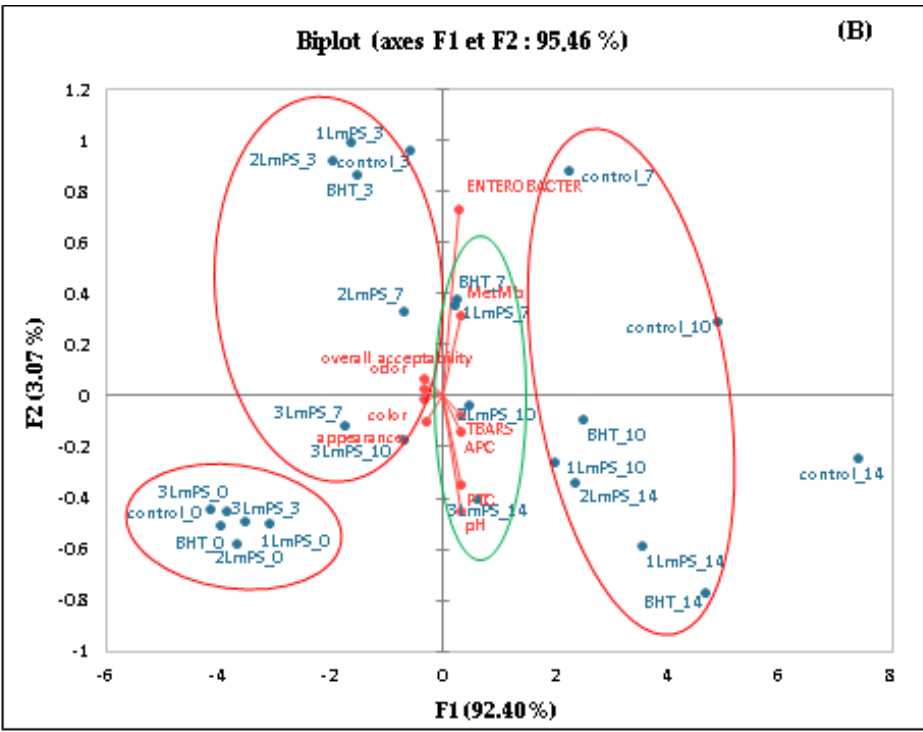
Figure 3. Principal component analysis (PCA) of meat data. ( A ) Scatterplot of PCA. ( B ) Biplot of PCA.